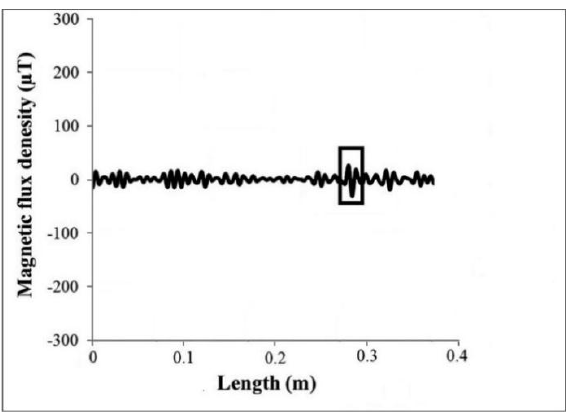
Figure 18. Magnetic flux density values at different axes (X, Y and Z) in the Y direction at the surface of the rebar (rebar mesh #8 and box mesh #5).